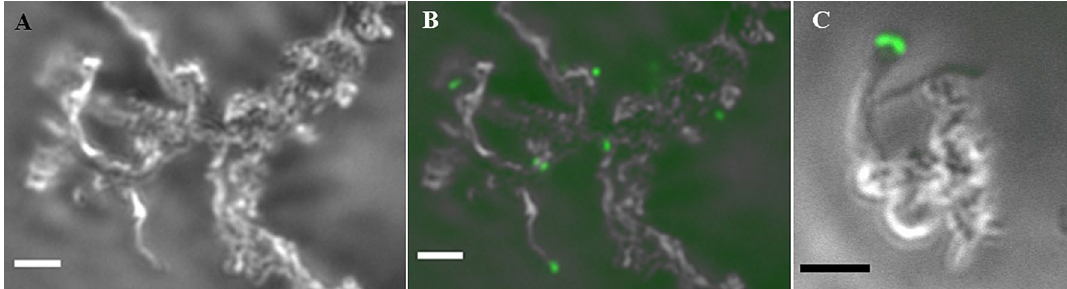
Figure 2. Expression of green fluorescent protein in M. ferrooxydans . ( a ) Light micrograph showing the characteristic twisted stalks produced by M. ferrooxydans containing a plasmid with gfpmut2 and grown in the presence of 200 µg/mL kanamycin. ( b , c ) Composite images of light and epifluorescent micrographs showing the green fluorescent cells attached to the stalks. Scale bars indicate 5 µm.